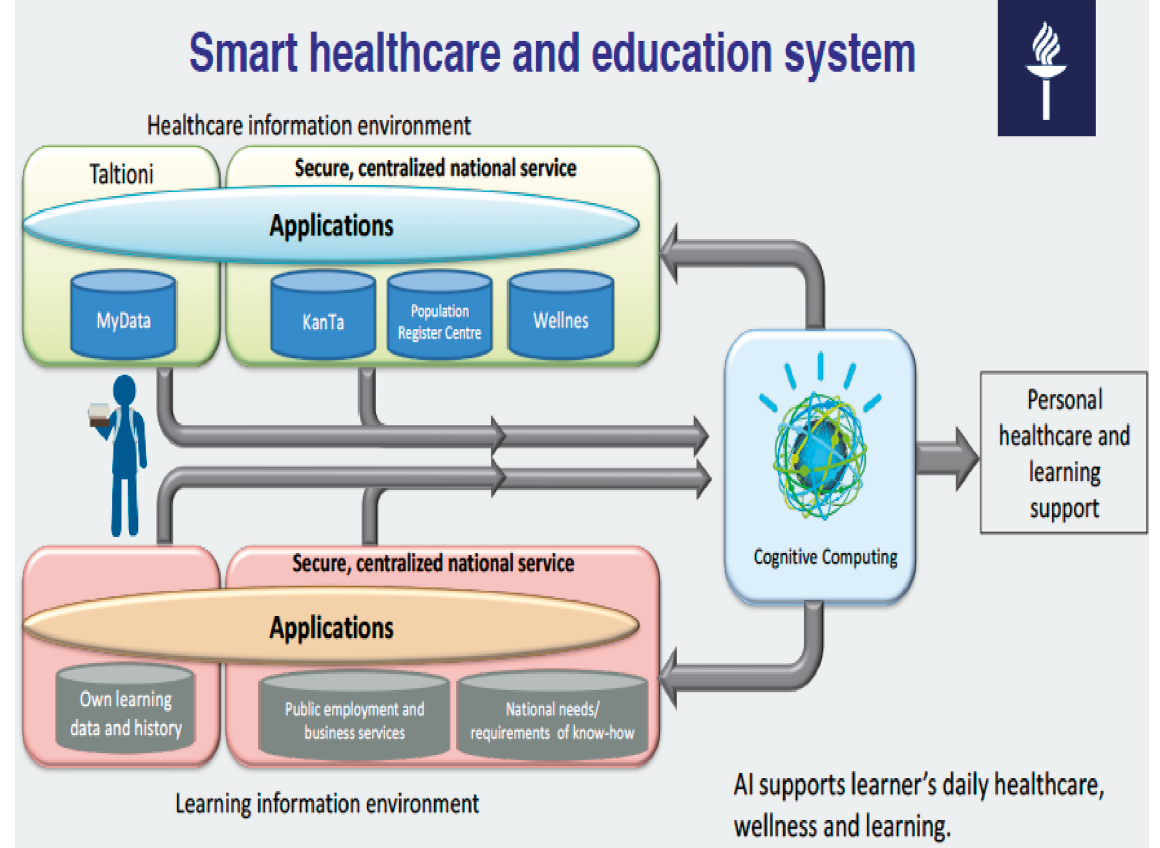
Figure 5: Cognitive computing in Finnish smart health care and education system in the future